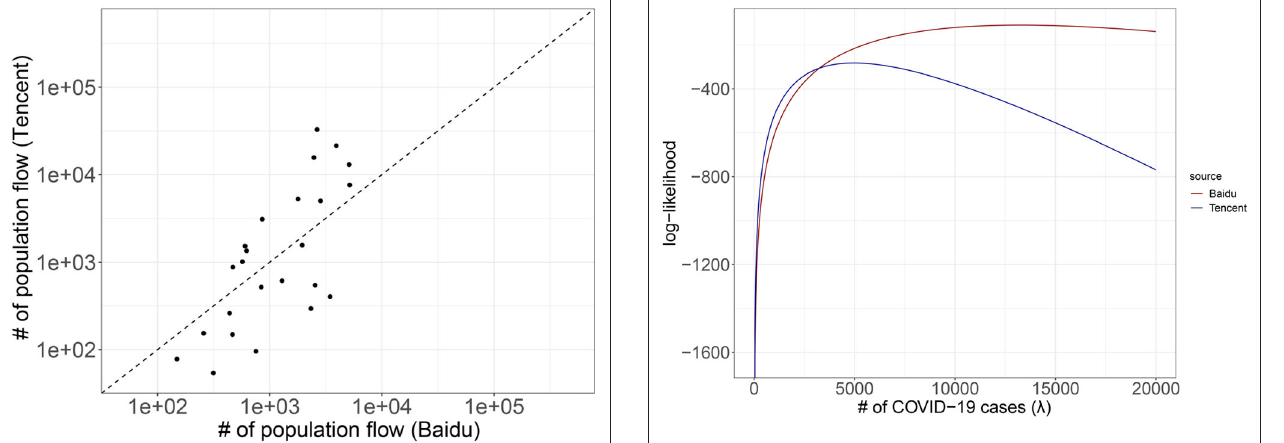
FIGURE 2 | Comparison between the number of population flow data from Baidu and Tencent. Y-axis presents the number of population flow between Wuhan and other cities/regions from Tencent data. X-axis presents the number of population flow between Wuhan and other cities/regions from Baidu data.